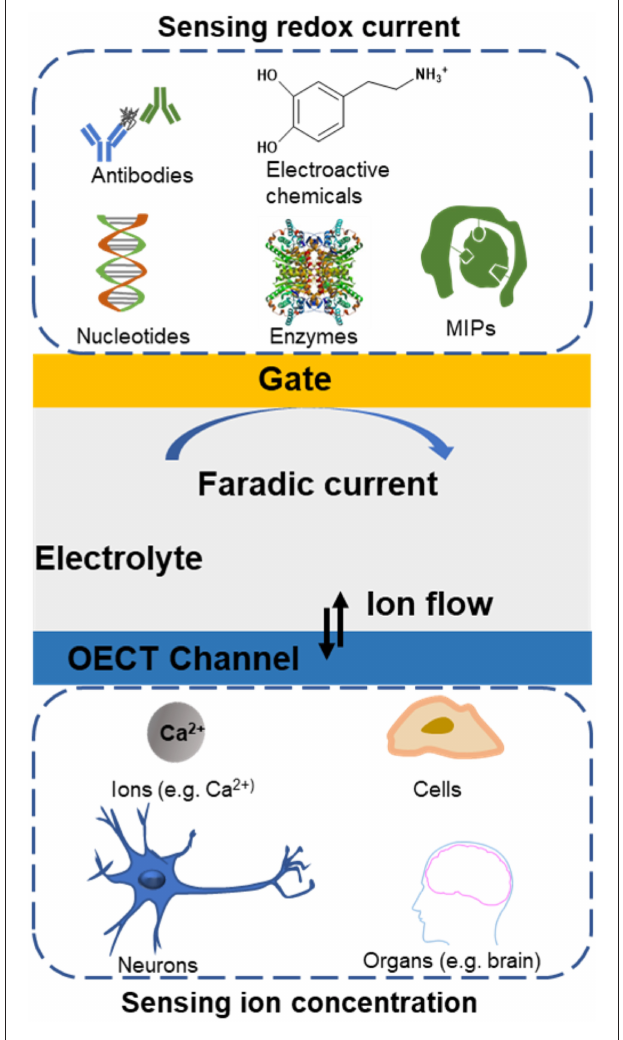
FIGURE 1 | Overview of biological systems applications based on organic electrochemical